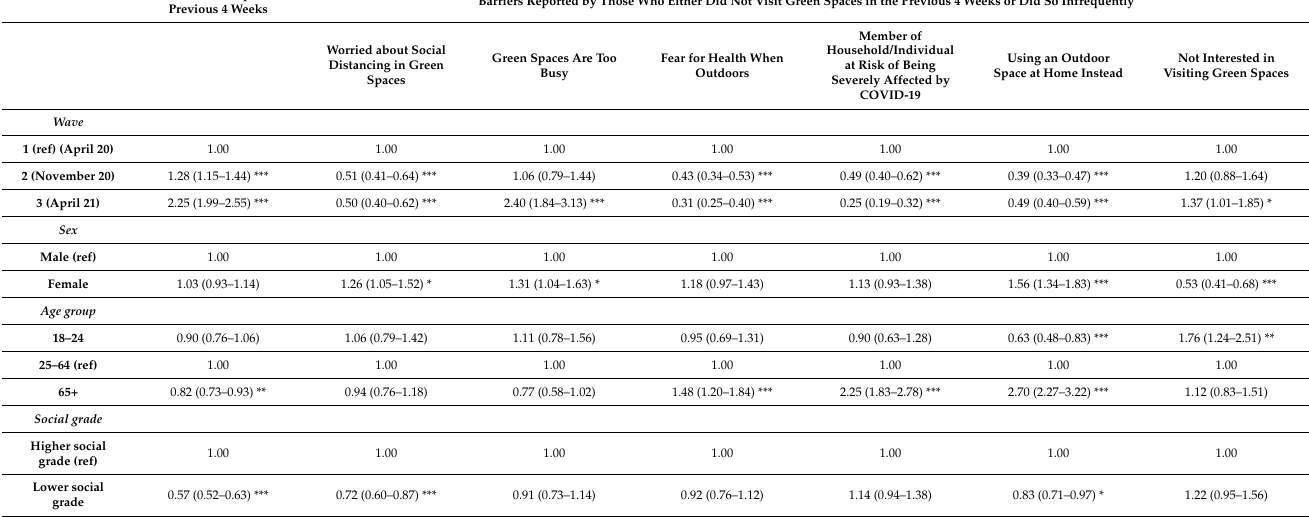
Table 3. Odds ratios (95% CI) from logistic regression models predicting either visiting green space or reported barriers to